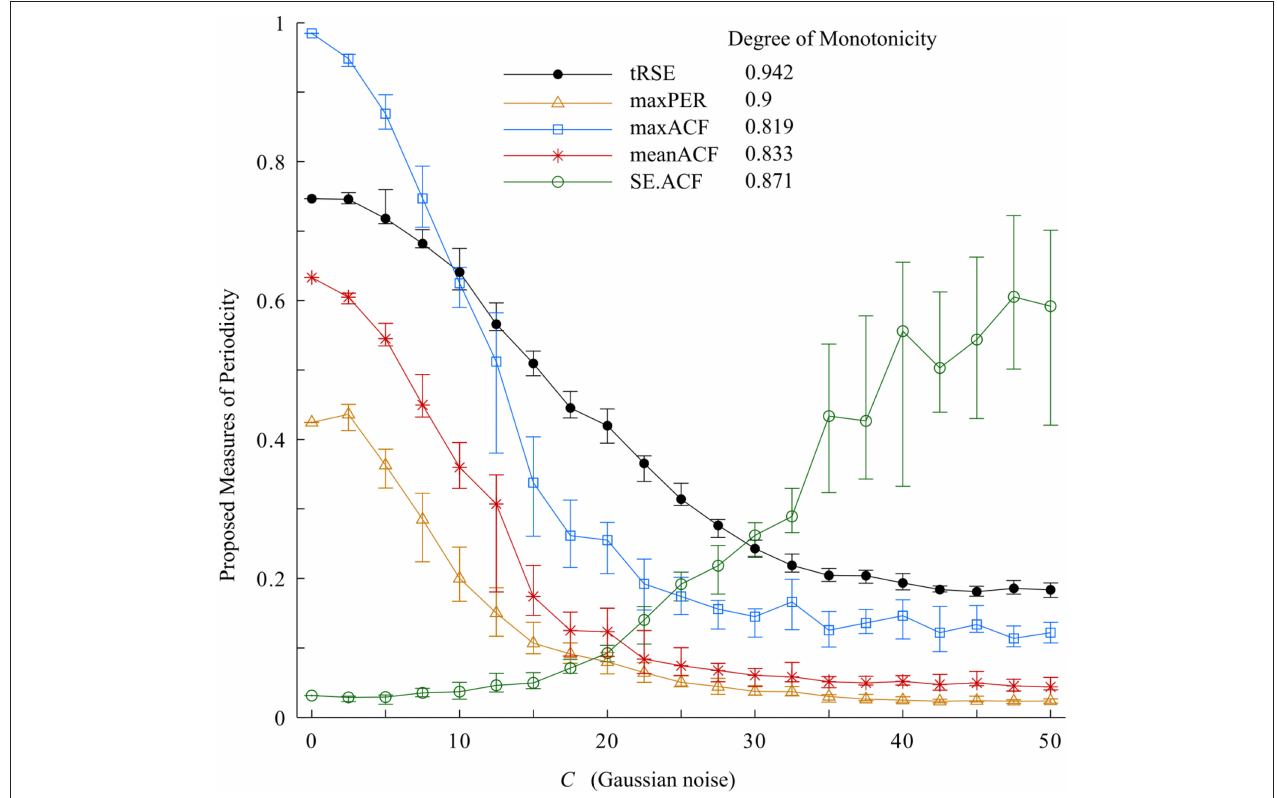
FIGURE 4 | Variability indices and the degree of monotonicity. Of these measurements, tRSE was sensitive to monotonicity over a broad bandwidth.